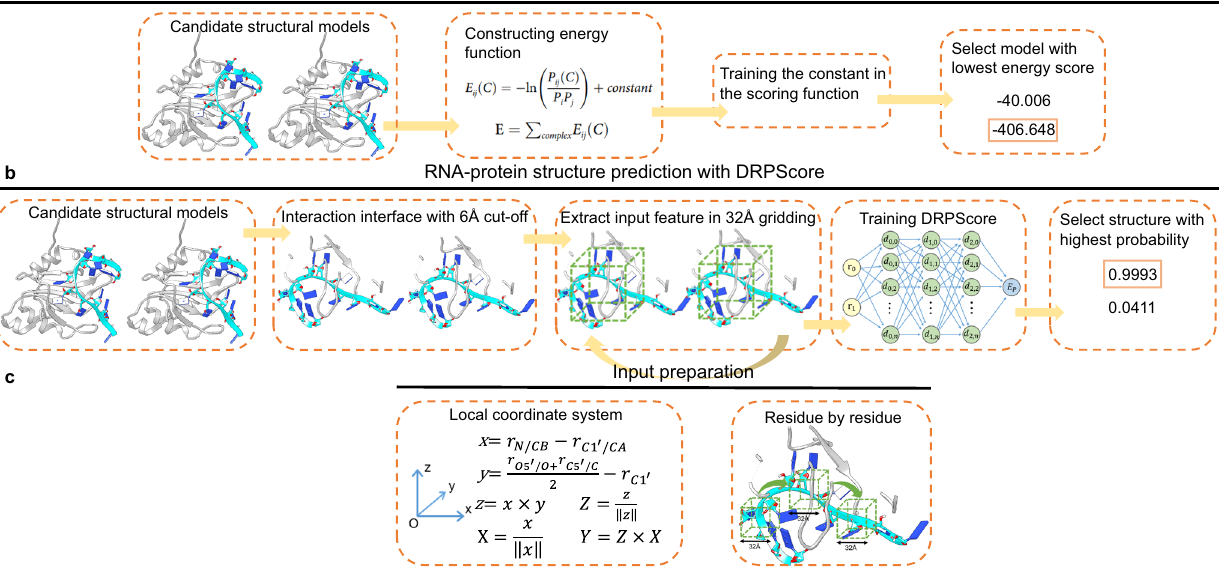
evaluate decoys. b The steps of DRPScore to evaluate the decoys. c The local coordinate framework construction in the generated 32Å